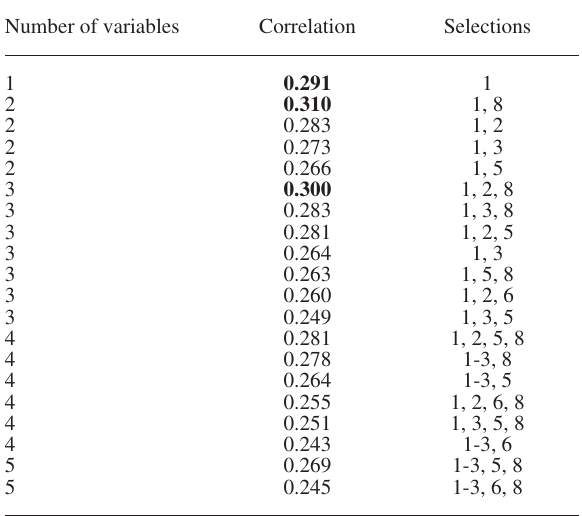
Table 7. – result of bioenV analysis to select the number of abiotic variables which best match the biotic matrix. bold values indicate best matches. Variables: 1, depth; 2, eh; 3, organic matter (%); 4, gravel (%); 5, coarse sand (%); 6, medium sand (%); 7, fine sand (%); 8, mud